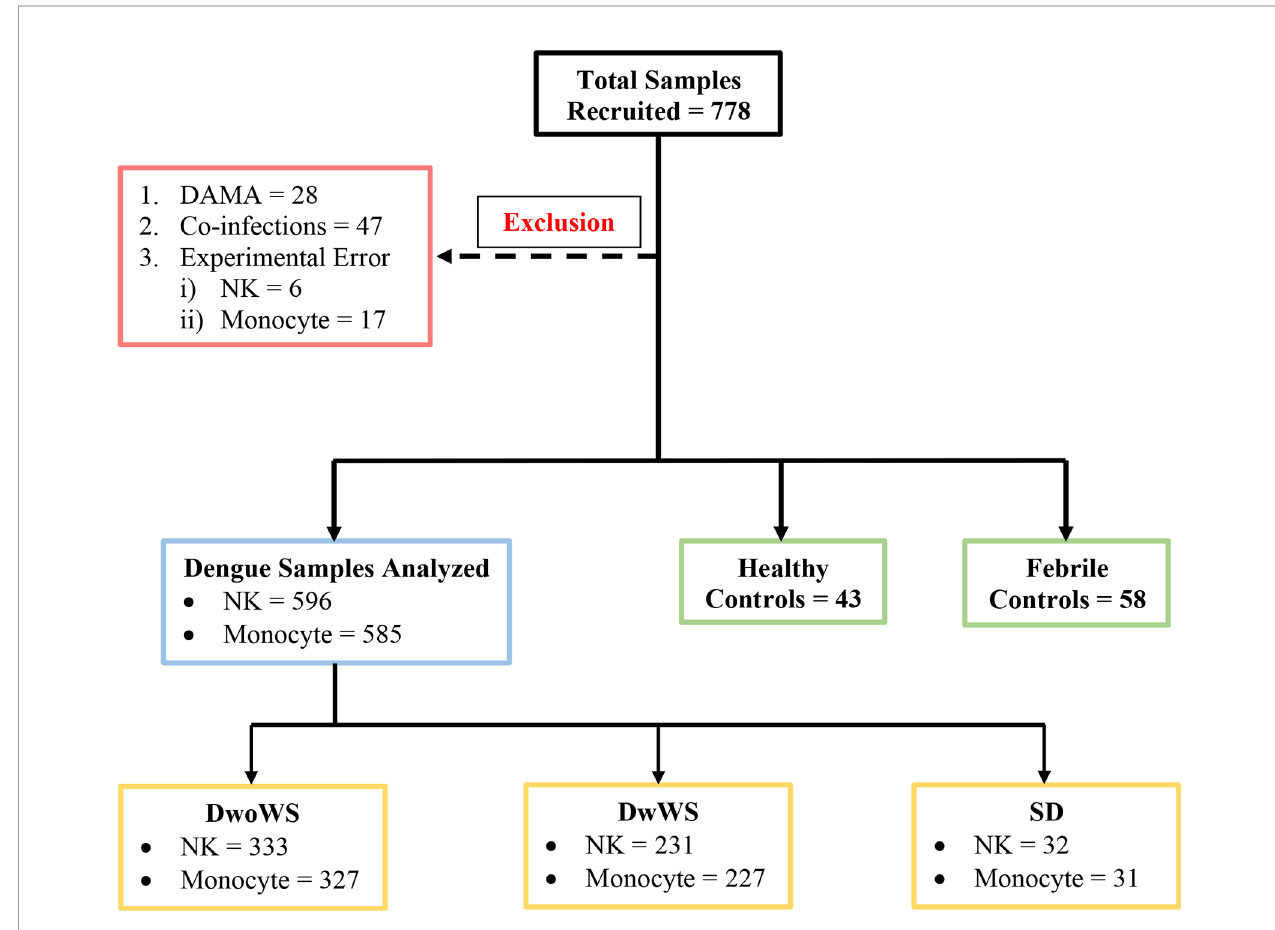
FIGURE 1 | Schematic of patient recruitment. A total of 778 patients were initially recruited; patients who were discharged against medical advice (DAMA), those with co-infections ( i.e. typhoid, sepsis, malaria, urinary tract infection, hepatitis B infection), and samples with experimental errors were excluded as shown. DwoWS, dengue without warning signs; DwWS, dengue with warning signs; SD, severe dengue; NK, natural killer